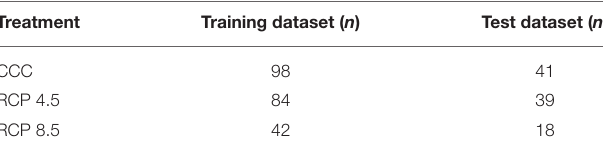
TABLE 3 | Sample size (n) of the training and test databases created for each growth